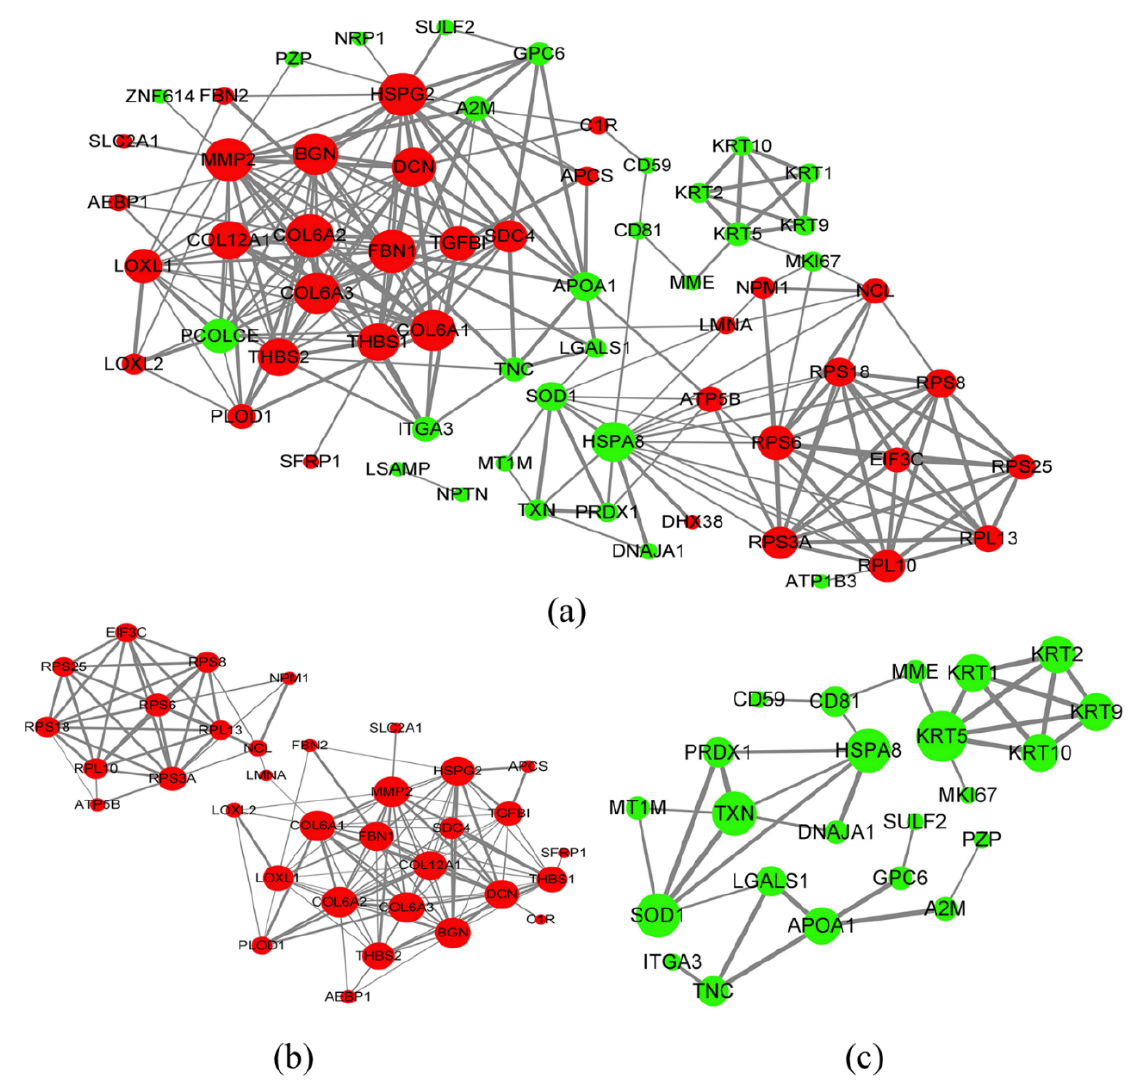
Figure 6. Protein-protein interaction network obtained using STRING and Cytoscape software in differentially-expressed proteins in Hypo-Exos vs. Nor-Exos. Upregulated and downregulated proteins are indicated by the red and green nodes, respectively. The greater the number of interacting proteins, the bigger the nodes. The stronger the data support, the thicker the line. ( a ) Network of proteins obtained in all the DEPs. ( b ) Network of proteins obtained in the upregulated DEPs. ( c ) Network of proteins obtained in the downregulated DEPs.